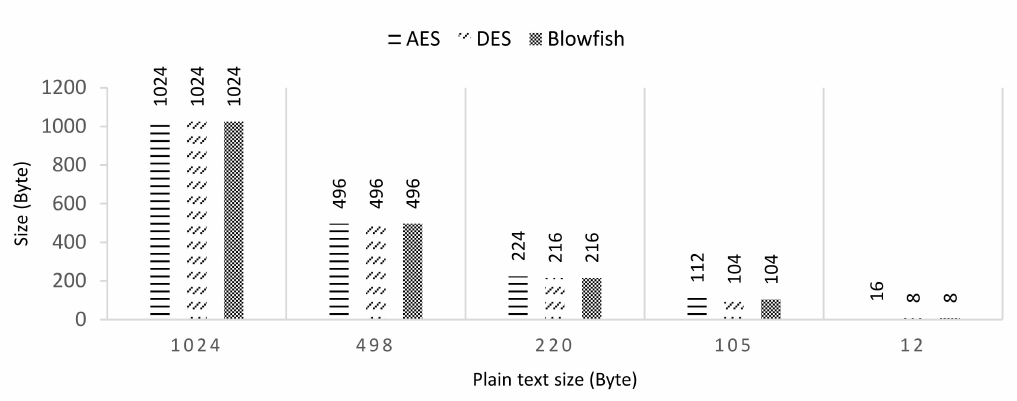
Figure 5. Evaluation of varying plain text